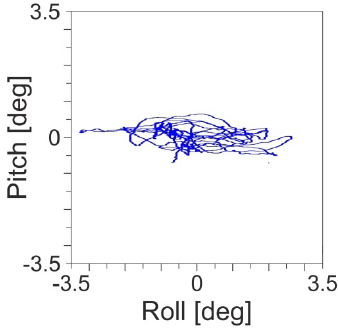
Figure 2. Example of a two-dimen- sional trajectory of the roll vs.